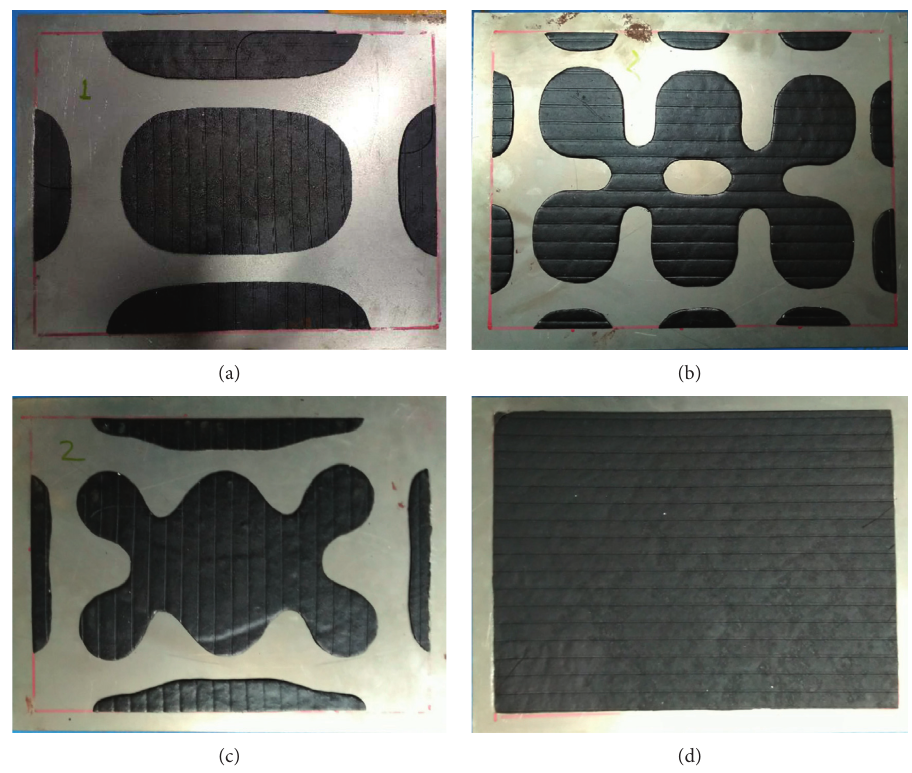
Figure 18: The images of the plates with different damping distributions.